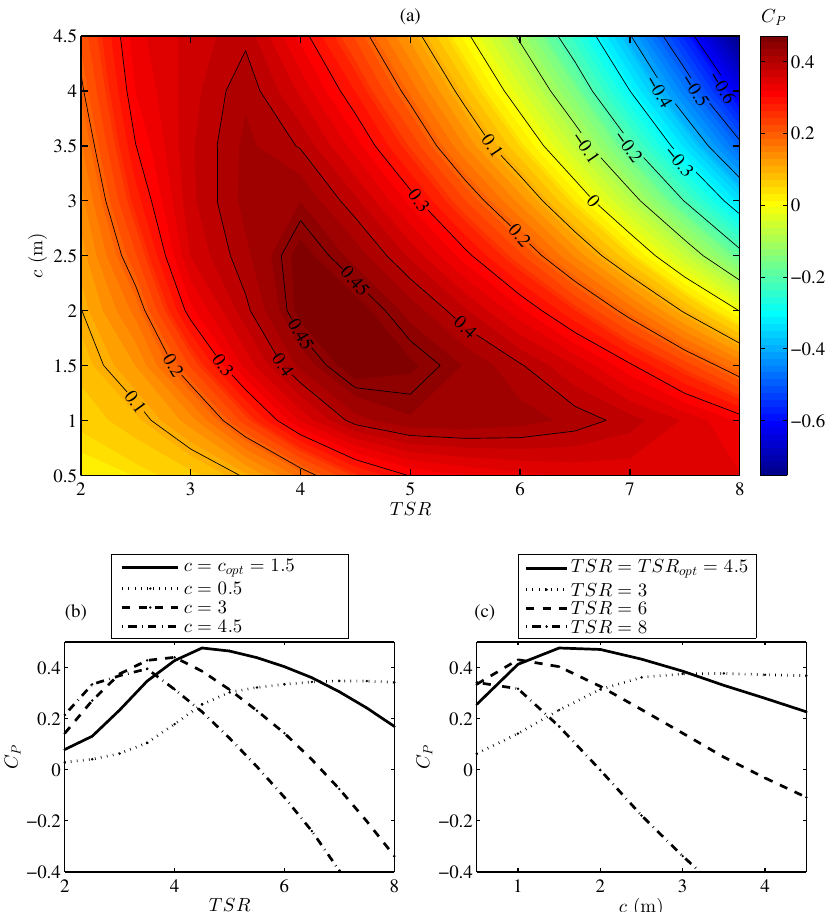
Figure 4. Variation of the power coefficient of a three-bladed VAWT with tip-speed ratio ( TSR ) and chord length: ( a ) C P as a function of both TSR and chord length; ( b ) C P as a function of TSR for four different chord lengths; ( c ) C P as a function of chord length for four different TSR